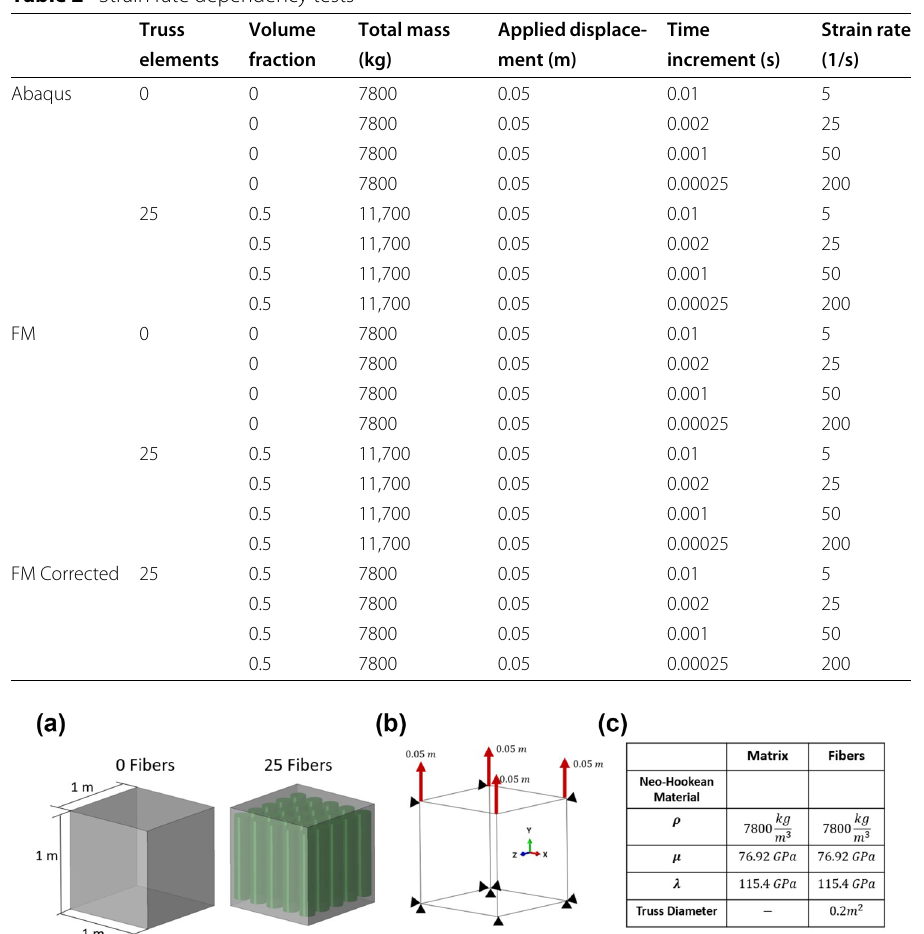
Fig. 13 Set up of the strain rate dependency tests, a images of 0 and 25 fiber meshes, b test boundary conditions, c matrix and fiber material